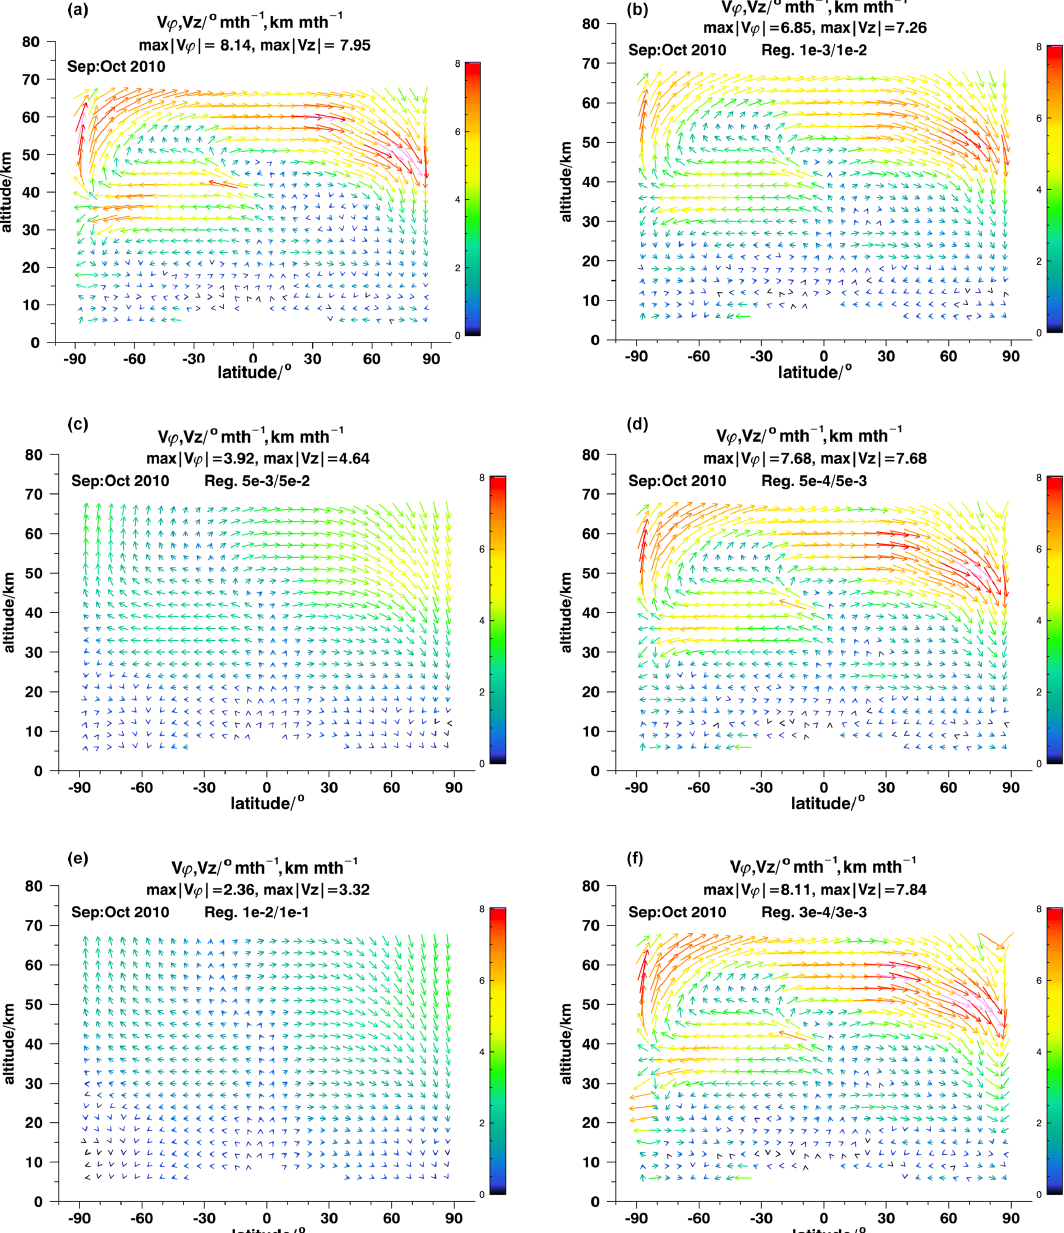
Figure 7. Resulting fields of effective velocity for different regularization strengths. Panel (a) shows the reference velocity distribution and panel (b) the model recovery test for the nominal regularization strength of (c 1 × 1 . 0 × 10 − 3 ) 2 for horizontal velocities and (c 2 × 1 . 0 × 10 − 2 ) 2 for vertical velocities. Panels (c) and (e) show results for stronger regularization of ((c 1 × 5 . 0 × 10 − 3 ) 2 ; (c 2 × 5 . 0 × 10 − 2 ) 2 ) and ((c 1 × 1 . 0 × 10 − 2 ) 2 ; (c 2 × 1 . 0 × 10 − 1 ) 2 ) , respectively. Panels (d) and (f) show results for weaker regularization of ((c 1 × 5 . 0 × 10 − 4 ) 2 ; (c 2 × 5 . 0 × 10 − 3 ) 2 ) and ((c 1 × 3 . 0 × 10 − 4 ) 2 ; (c 2 × 3 . 0 × 10 − 3 ) 2 ) ,